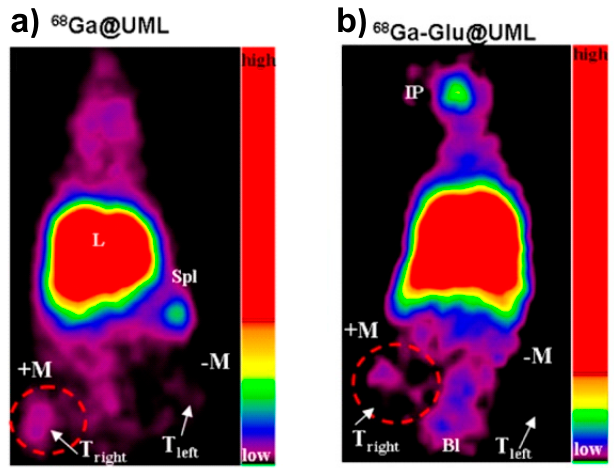
Figure 7. ( a ) PET image 30 min post 68 Ga radiolabeled liposome injection (without glucose in the formulation); and ( b ) PET image 30 min post 68 Ga radiolabeled glucose liposome injection. The arrows show tumors. IP, injection point; K, kidneys; L, liver; Spl, spleen; Bl, bladder; M, magnet; T right and T left , tumors. Adapted from Malinge et al.